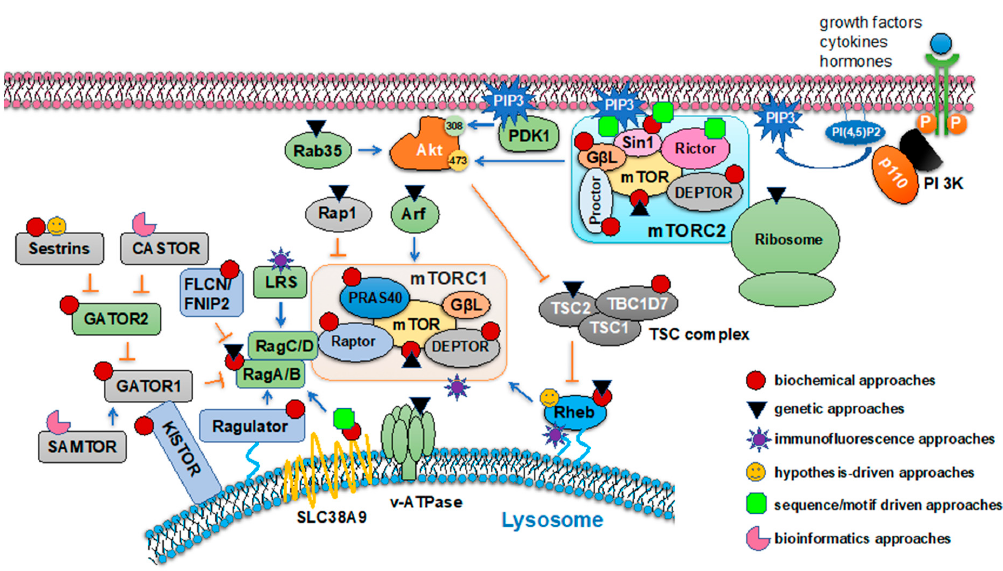
Figure 1. Summary of experimental approaches used in identification of major mTOR signaling components. This schematic illustrates six types of experimental approaches used in identification of key mTOR signaling pathway members by shapes denoted in the figure.